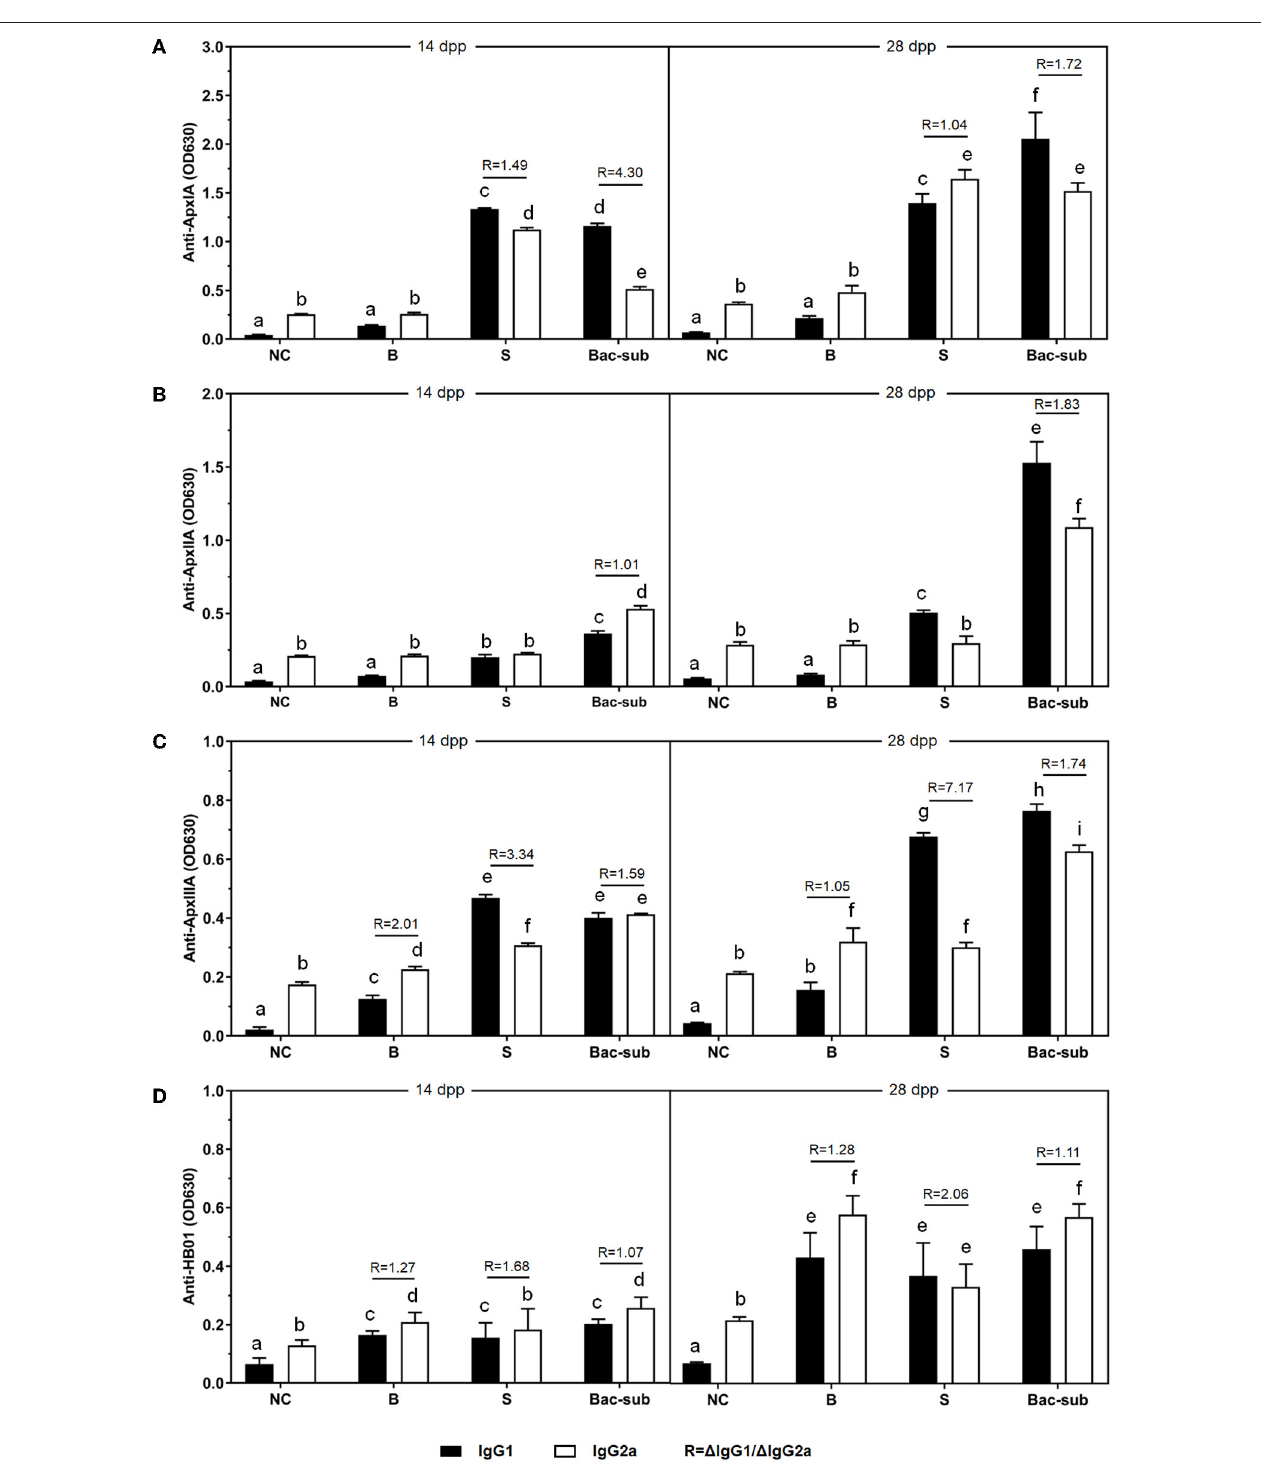
FIGURE 3 | The levels of IgG1 and IgG2a antibodies (OD 630nm ) against ApxIA (A) , ApxIIA (B) , ApxIIIA (C) , and HB01 somatic antigens (D) induced by the Bac-sub vaccine, subunit vaccine (S), bacterin (B), and PBS (NC) in mice 7 days after priming and boosting vaccination. R = 1 IgG1/ 1 IgG2a, ( 1 means the value of the vaccinated group minus that of the NC group). Different letters at the top of columns mean that IgG1 or IgG2a titers are significantly different ( p < 0.05), otherwise not significant ( p > 0.05).